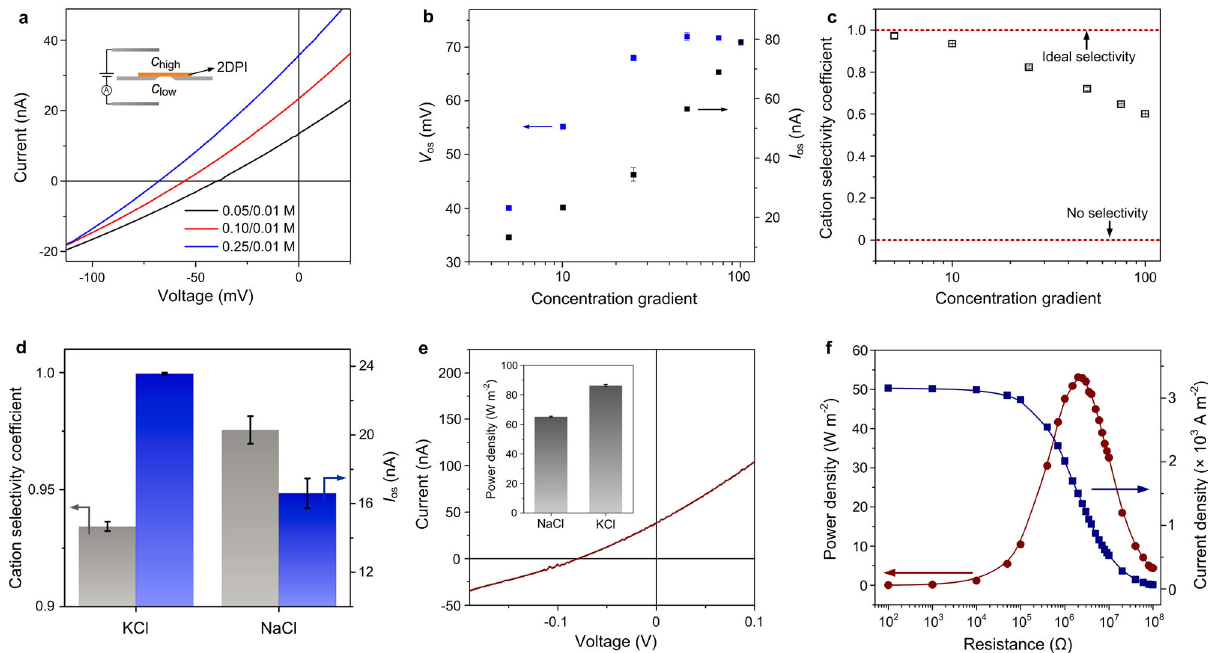
Fig. 3 Selective ion diffusion and osmotic energy conversion. a I – V curves of the 2DPI membrane recorded under a series of KCl concentration gradient (the low concentration side, c low , is set to 0.01 M). b Variations of V os and I os as a function of KCl concentration gradient. c The ion selectivity coef fi cient as a function of KCl concentration gradient. d Comparison of the ion selectivity coef fi cient and I os in NaCl and KCl electrolyte with a concentration gradient of 10-fold. e I – V curve of the 2DPI membrane recorded under 0.5/0.01 M NaCl. (Inset: comparison of the power density in KCl and NaCl of same concentration gradient, 0.5/0.01 M). f Power generation on external circuit by mixing arti fi cial river water and seawater. Error bars represent